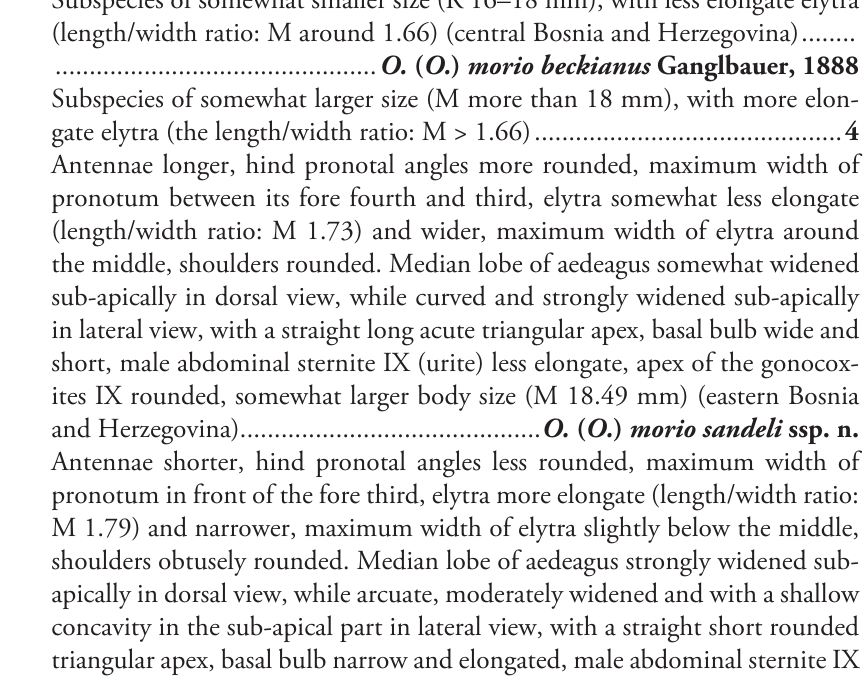
Figure 14. The distribution of Omphreus ( Omphreus ) morio subspecies. Scale bar 50 km.